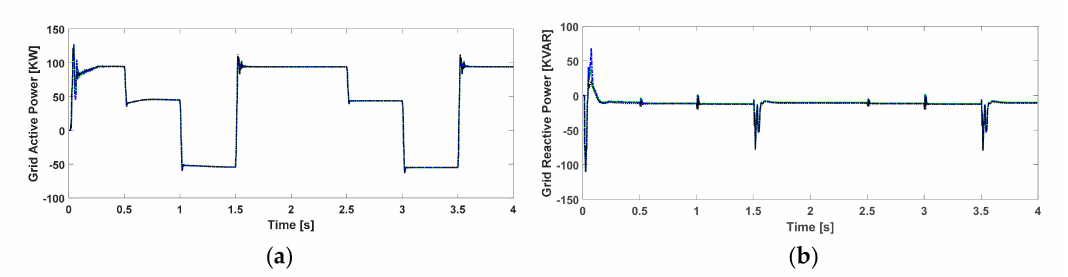
Figure 15. Power flow through CB8 during fault-free operation: ( a ) active power, and ( b ) reactive